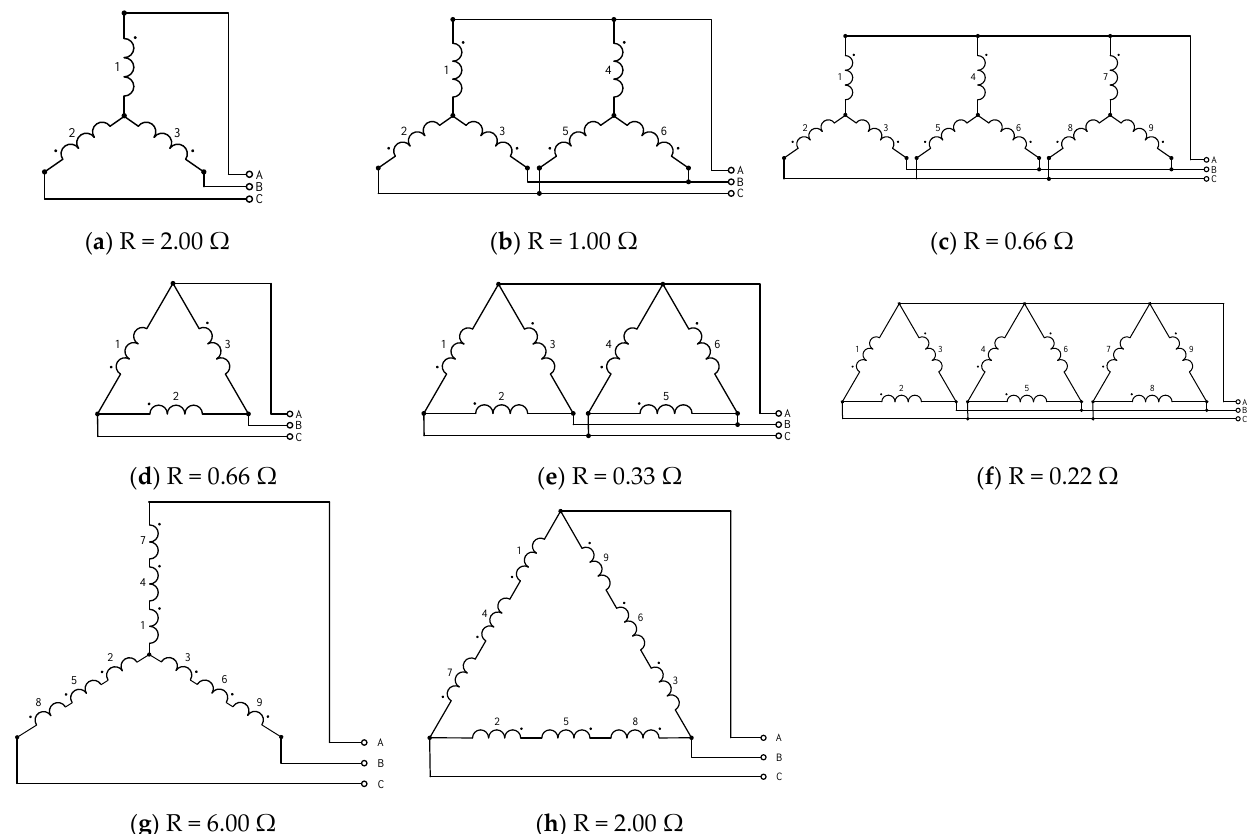
Figure 6. Winding interconnection of the BLDC motor tested with the DC resistance indicated.